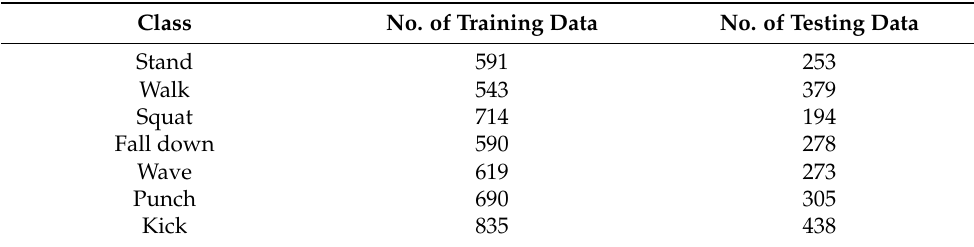
Table 2. Number of data used for training and testing.